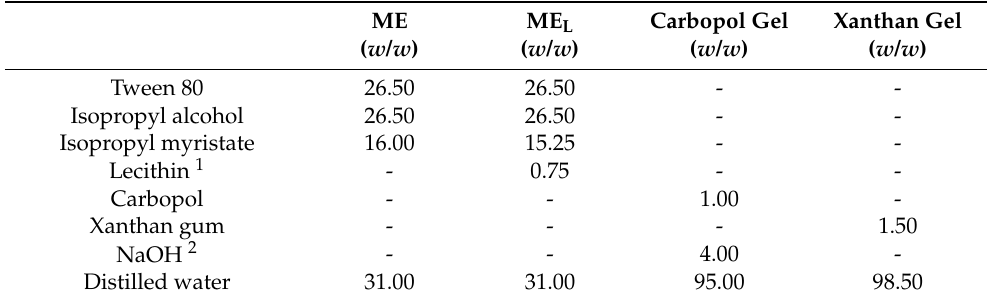
Table 1. The composition of the microemulsions and the gels.